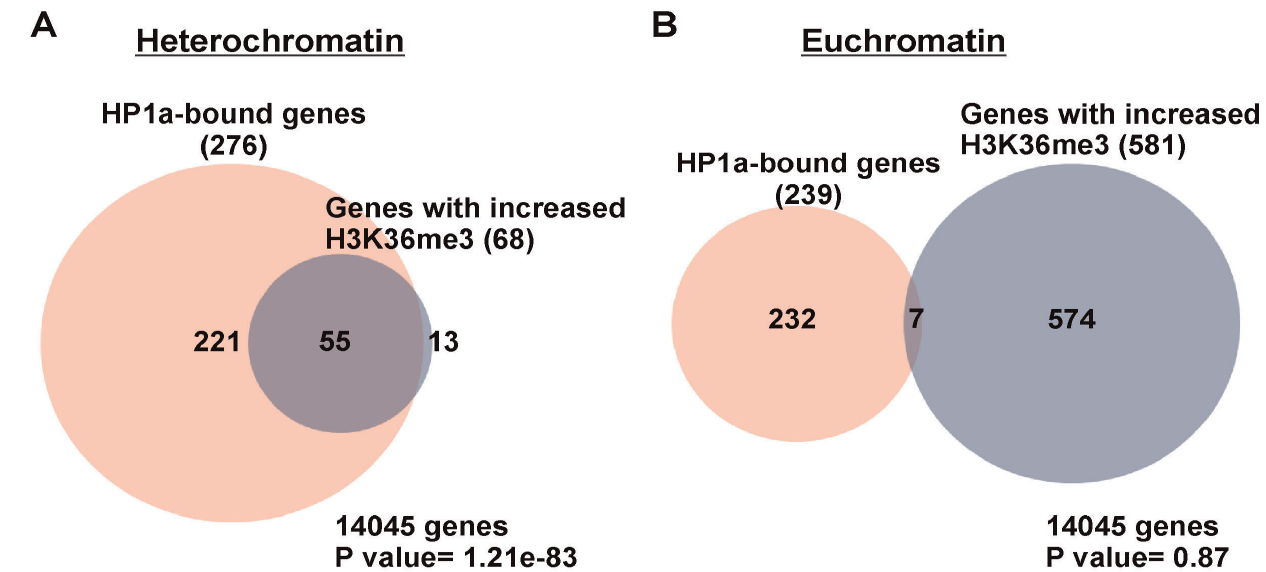
Figure 2. Identification of Common Target Genes of dKDM4A and HP1a. The Venn diagram analysis of heterochromatic genes (A) or euchromatic genes (B) bound by HP1a in wild type and genes with increased H3K36me3 levels in dkdm4a mutant embryos. Genes assigned to the chromosome U are not included in the analysis. The P value was calculated by the hypergeometric test.